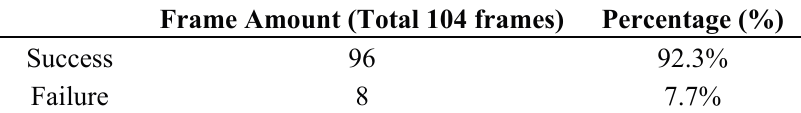
Table 4. The success rate and the failure rate for obstacle